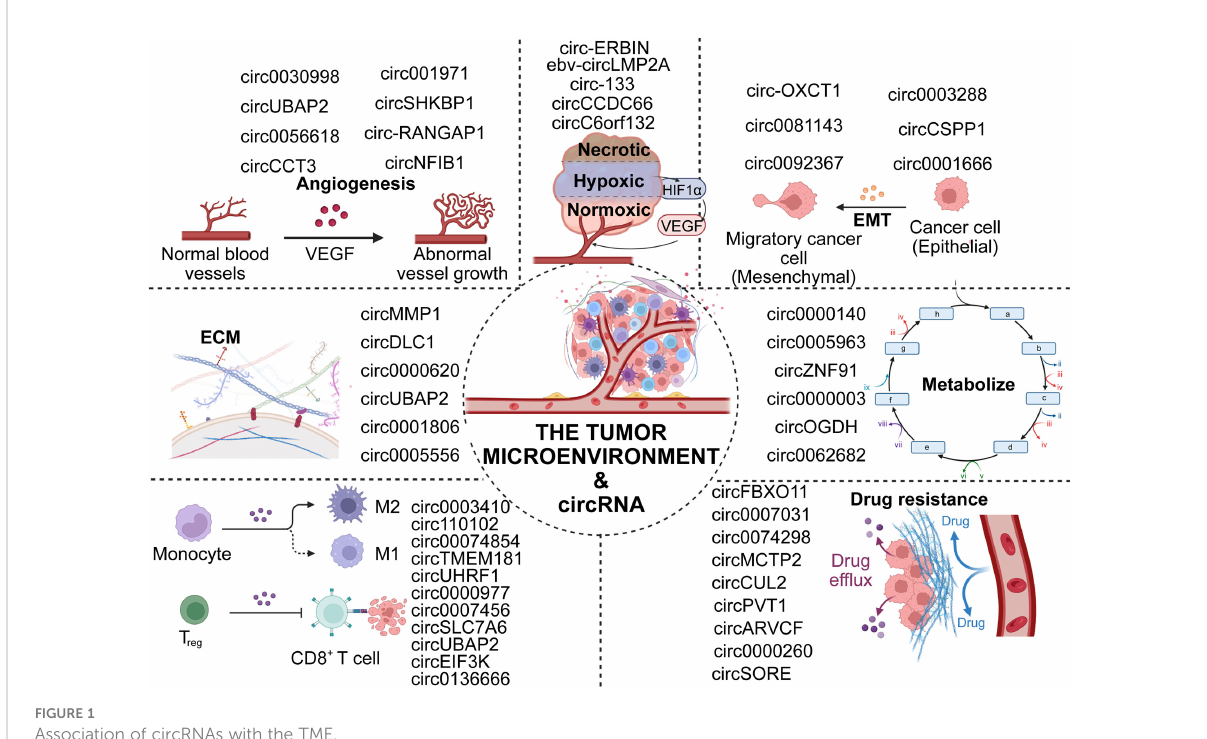
FIGURE 1 Association of circRNAs with the